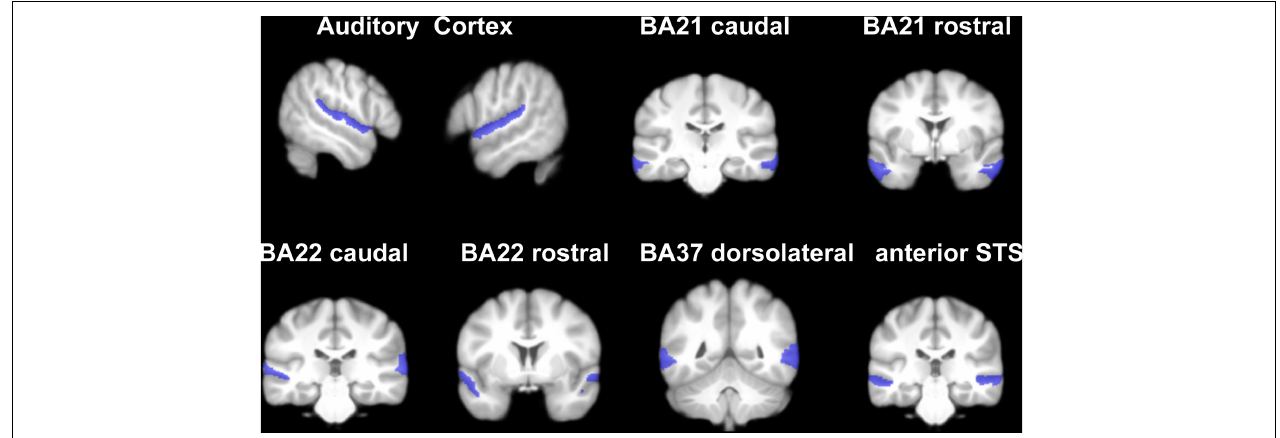
FIGURE 2 | Anatomic representation of the auditory-related areas ROIs within the Brainnetome atlas.